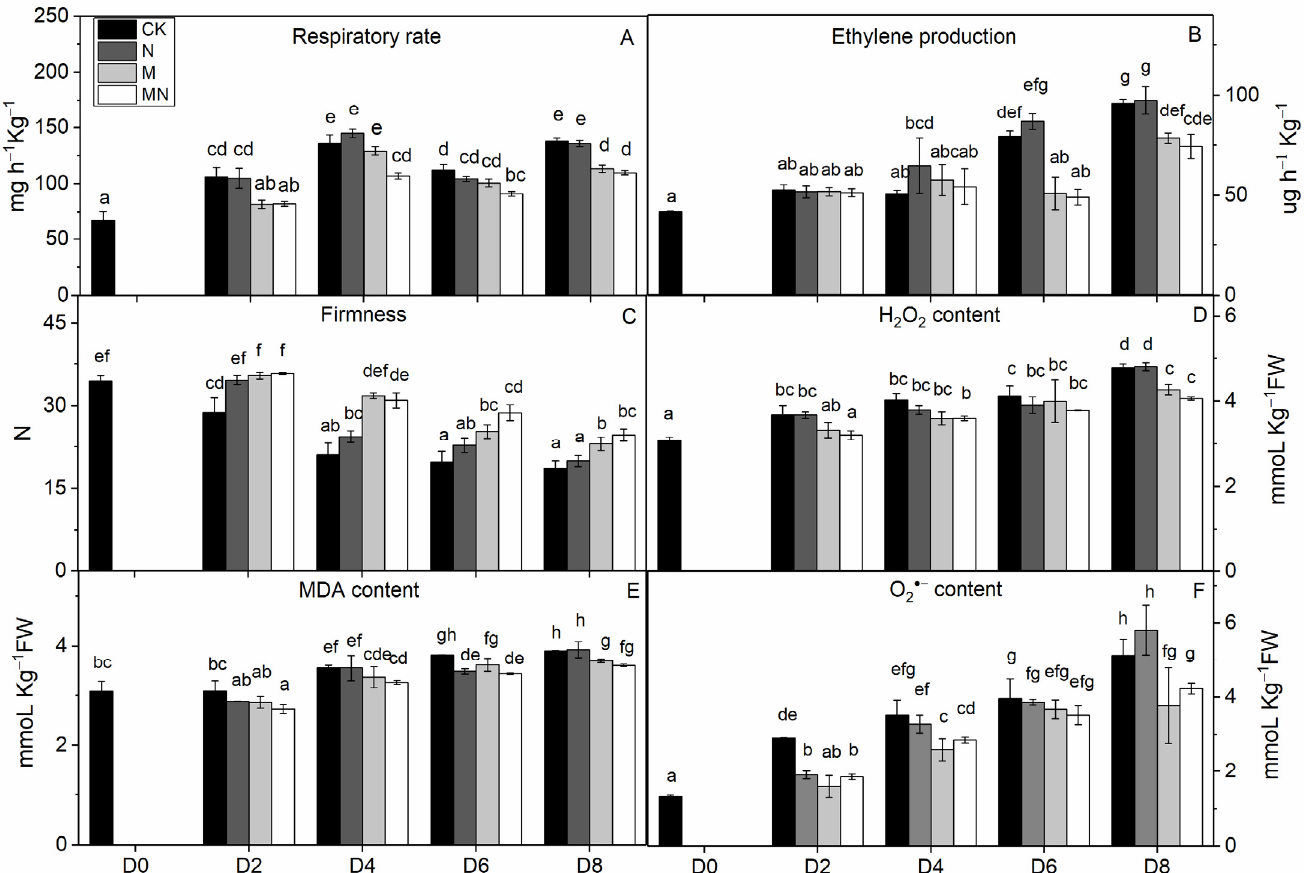
Figure 1. Physiological and biochemical indices of peach fruit including respiratory rate ( A ), ethylene production ( B ), firmness ( C ), H 2 O 2 content ( D ), MDA content ( E ) and O 2 − content ( F ) used in this research. Each point represents means ± SE of three replicates. The lowercase letters indicate significant differences according to statistical analysis.